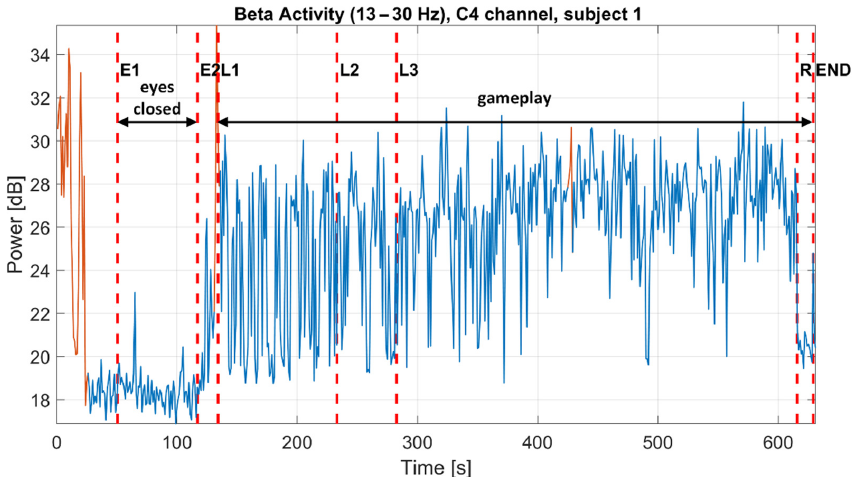
Figure 6. The average PSD of the beta activity (13–30 Hz) of the subject 1. The average power of alpha activity is computed in the same manner. As seen from Figure 7, the alpha activity also raised during the gameplay when subject 1 is examined.